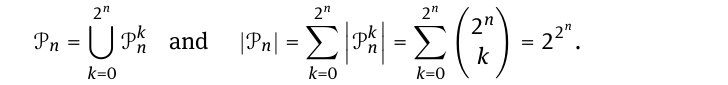
P for all c ∈ P with the property that precisely k elements of B , and write P k n n n n ⊂